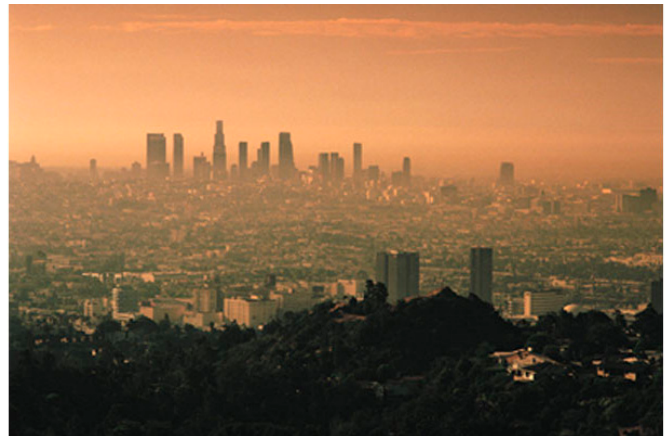
Figure 3. Photochemical smog appearing in the Greater Los Angeles area, USA. (Source: United States Geological Survey); see, e.g., https://serc.carleton.edu/eet/aura/case_study.html (accessed 10 November 2018).